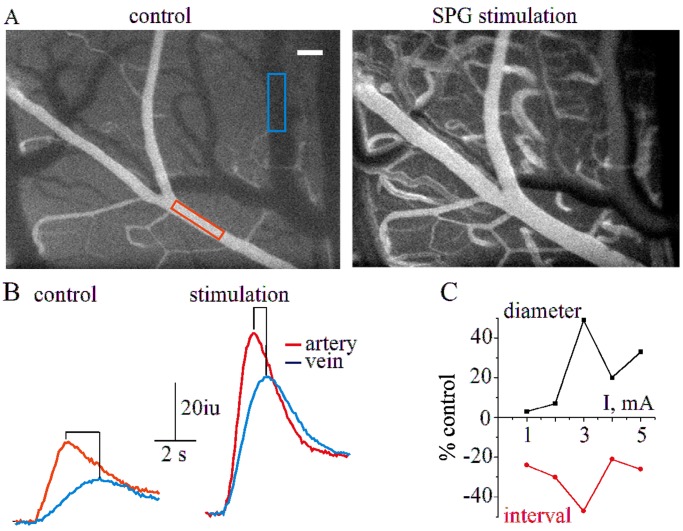
Fluorescent angiography during SPG stimulation A, Two representative angiographic images of cortical surface vessels under control conditions (left) and during SPG stimulation (3 mA, 500 µs, right, white bar represents 0.1 mm).B, Intensity curves (in arbitrary intensity units, iu) for the venous (blue) and arterial (red) compartments for the venous (blue) and arterial (red) compartments (marked in (A)) during control injection (left) and SPG stimulation (right). C, % change in diameter (black) and peak-to-peak (arterial-venous) interval (red) at different stimulation intensities (1–5 mA, 500 µs).